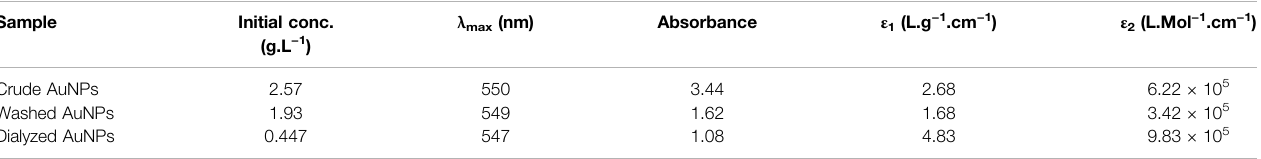
TABLE 1 | Comparison of the UV-visible maximum absorption along the puri fi cation process, in pure water ( ε 1 weight speci fi c absorbance; ε 2 estimated molar speci fi c absorbance).